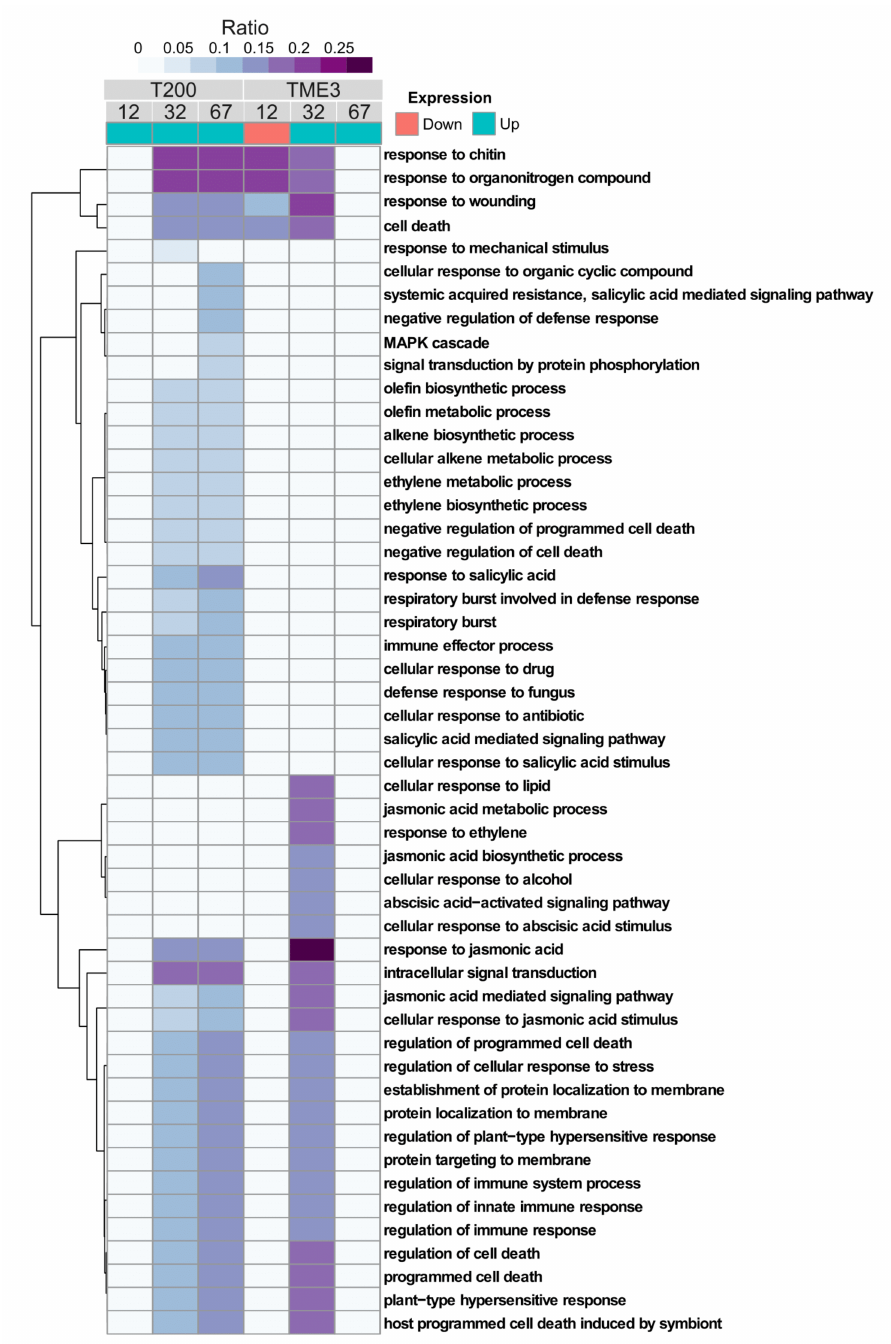
Figure 7. Heat map of significant (adjusted p value < 1 × 10 − 8 ) enriched GO terms from differentially expressed gene datasets in T200 and TME3 at 12, 32 and 67 days post South African cassava mosaic virus infection. The purple scale represents the ratio of regulated genes in each of the gene sets that fall into the enriched GO category. The blue bar blue represents upregulated genes and the red bar downregulated